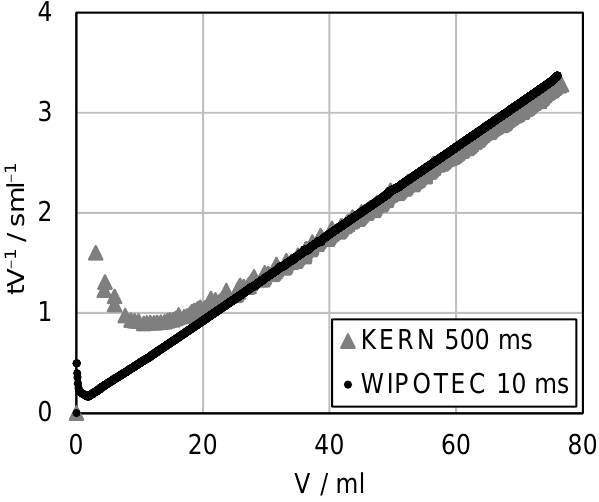
Figure 9. Effects of the balance. Nonwoven measured with 25 m% PCC at 0.8 bar.